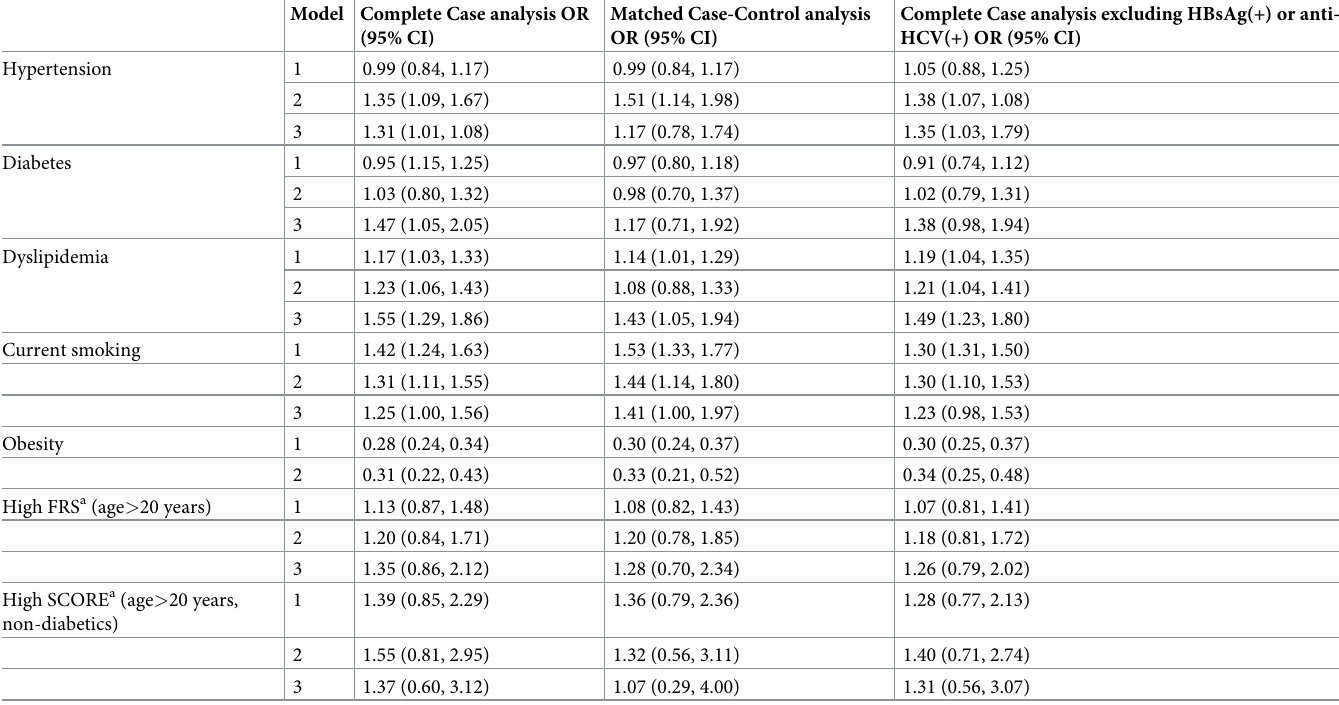
likely to be current smokers and dyslipidemic and had higher risk of fatal CVD, despite the fact that they were less likely to be obese; hypertension, diabetes, and FRS did not differ by HIV infection status. Further adjustment for educational level, anti-HCV positivity and BMI, Table 4. Adjusted odds ratio (OR) and 95% confidence interval (95% CI) of cardiovascular (CVD) risk factors and total CVD risk, comparing HIV-infected to the general population. Model Complete Case analysis OR (95%